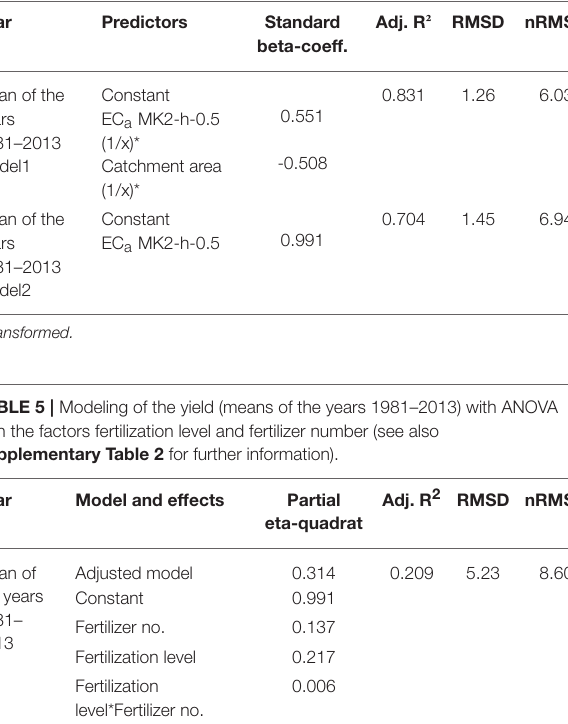
TABLE 7 | Simulation of the annual yield from 1981–2013 with REG of the control plots and the independent variables EC a , relief, and coordinates (further information is contained in Supplementary Table 4